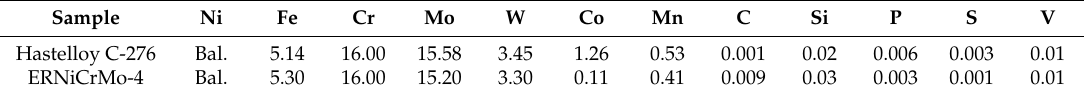
Table 1. Chemical composition of Hastelloy C ‐ 276 and ERNiCrMo ‐ 4 (wt. %).